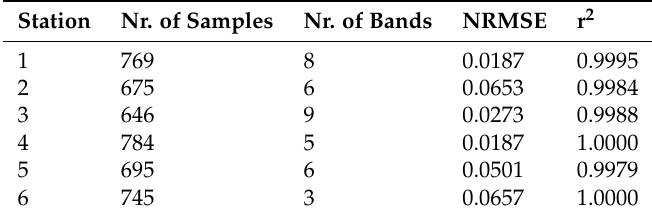
Table 6. Summary of the stationwise evaluation of AMSA for Chl-a for the merged dataset.